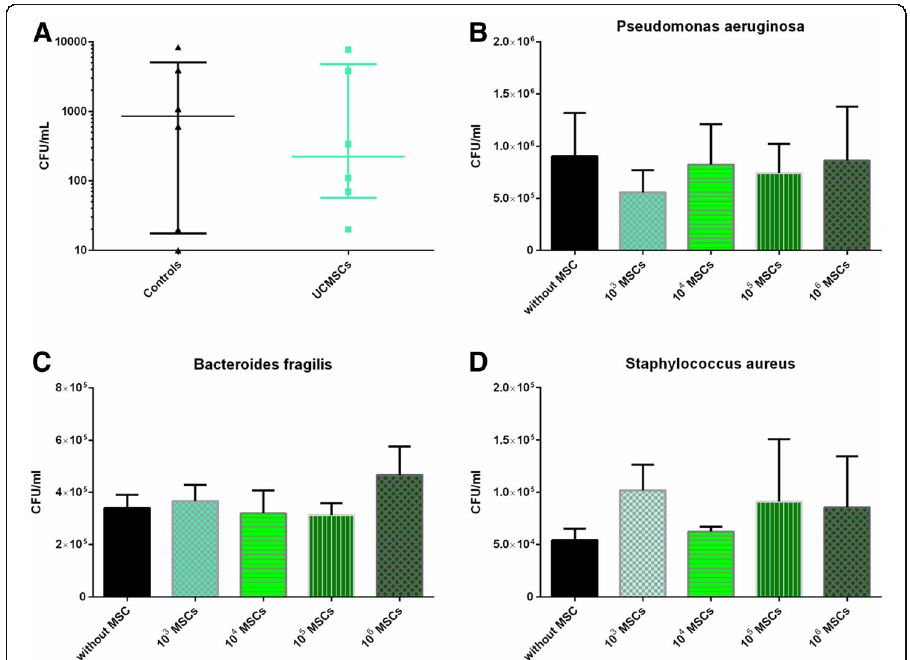
Fig. 4 UCMSCs have no antibacterial effect. Quantitative blood cultures at the time of death ( a ). The graph represents the medians and IQR of bacterial CFU ( n = 6 per group). UCMSCs were co-cultured at different concentrations with 10 4 to 10 5 CFU of three species of bacteria commonly found in intestinal microbiota: Pseudomonas aeruginosa ( b ), Bacteroides fragilis ( c ), and Staphylococcus aureus ( d ) ( n = 3 per group). CFU counts were determined by serial dilution and agar plating after 3 h of co-culture. Differences between groups were not statistically